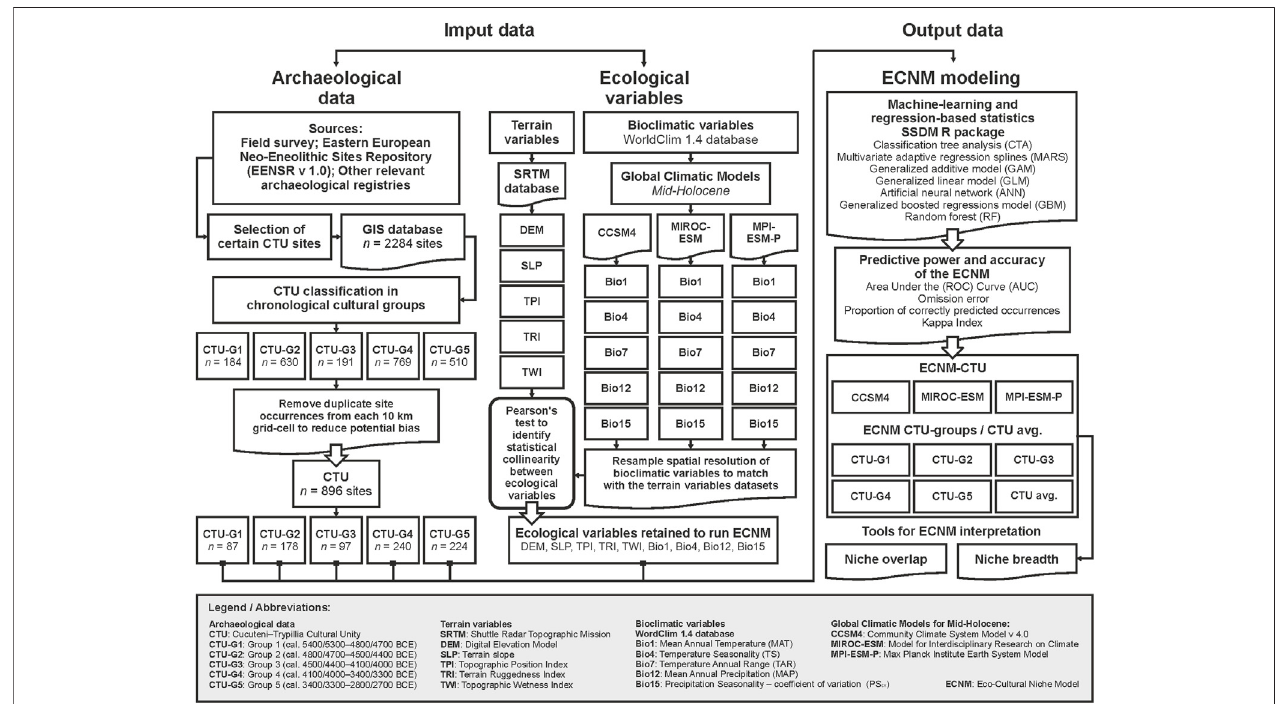
FIGURE2| Work fl owchartfollowedinthisstudy toobtain theeco-culturalniche(ECNM)breadthoftheCucuteni – Trypilliaculturalunity(CTU)during theEneolithic in Eastern Europe.